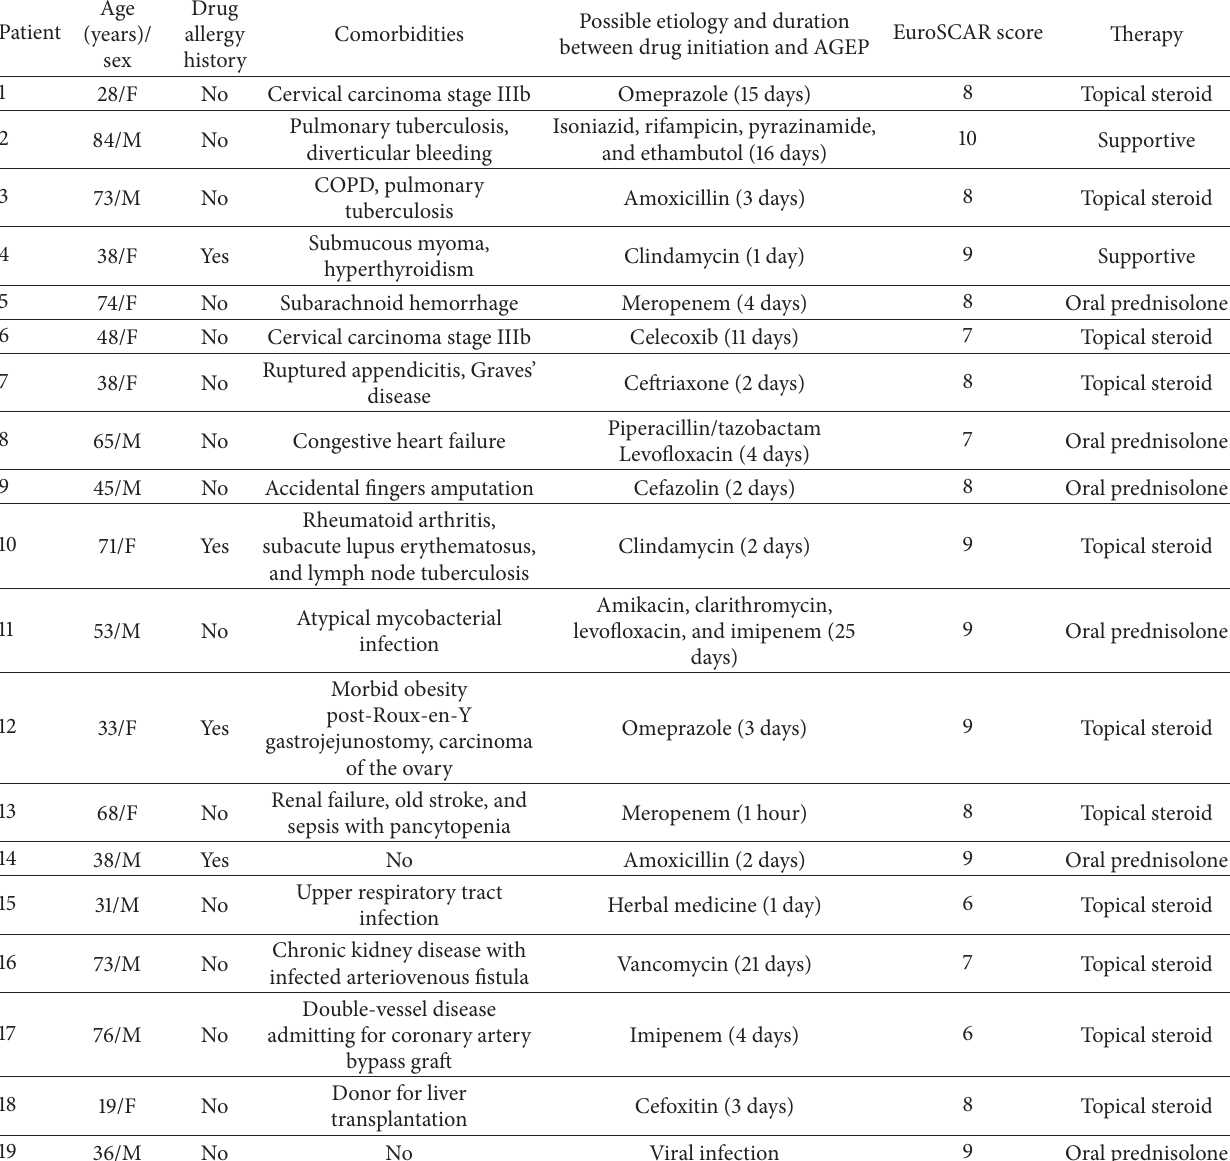
Table 2: Patient data (demographics, underlying disease, drug exposure, onset of symptoms, EuroSCAR AGEP validation, and therapy).